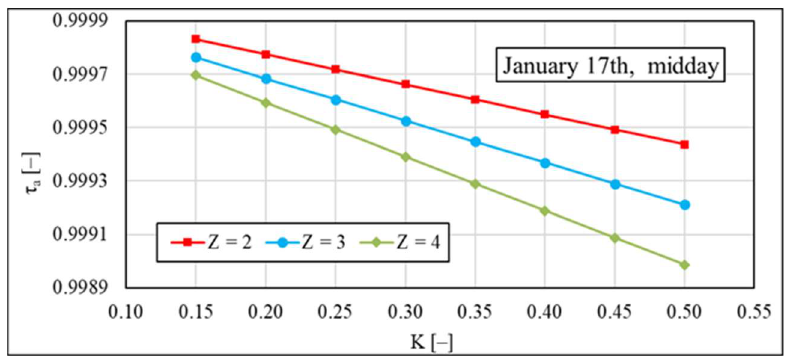
Figure 7. Transmissivity after accounting for absorption of solar radiation by polycarbonate as a function of extinction coefficient—17th of January, noon.